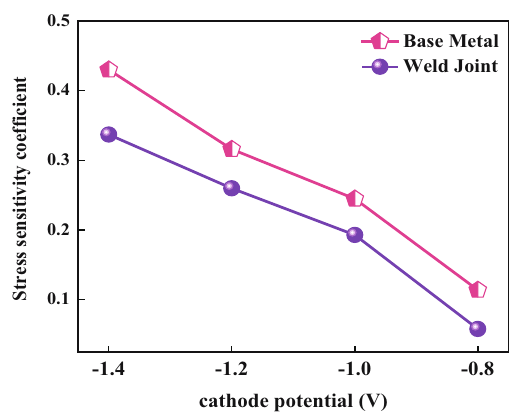
Figure 4: Polarization curves of 7N01 - T4 aluminum alloy base metal and joint weld